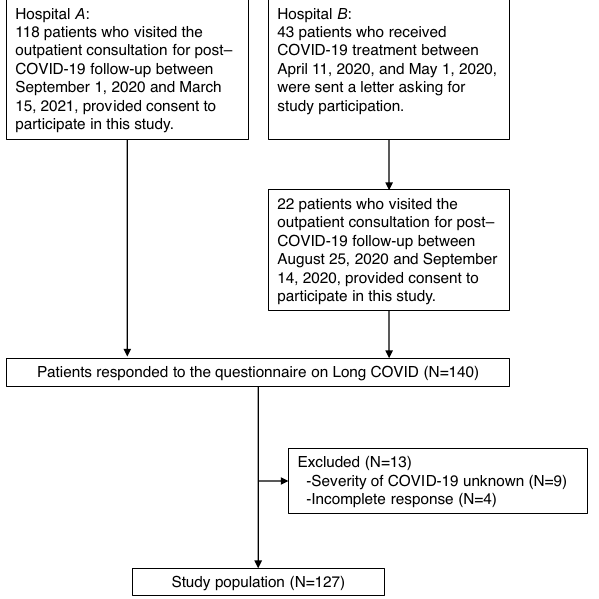
Figure 1. Selection of the study population. The study was conducted among COVID-19 survivors in two designated COVID-19 hospitals in Hiroshima Prefecture, Japan. A total of 127 COVID-19 survivors were